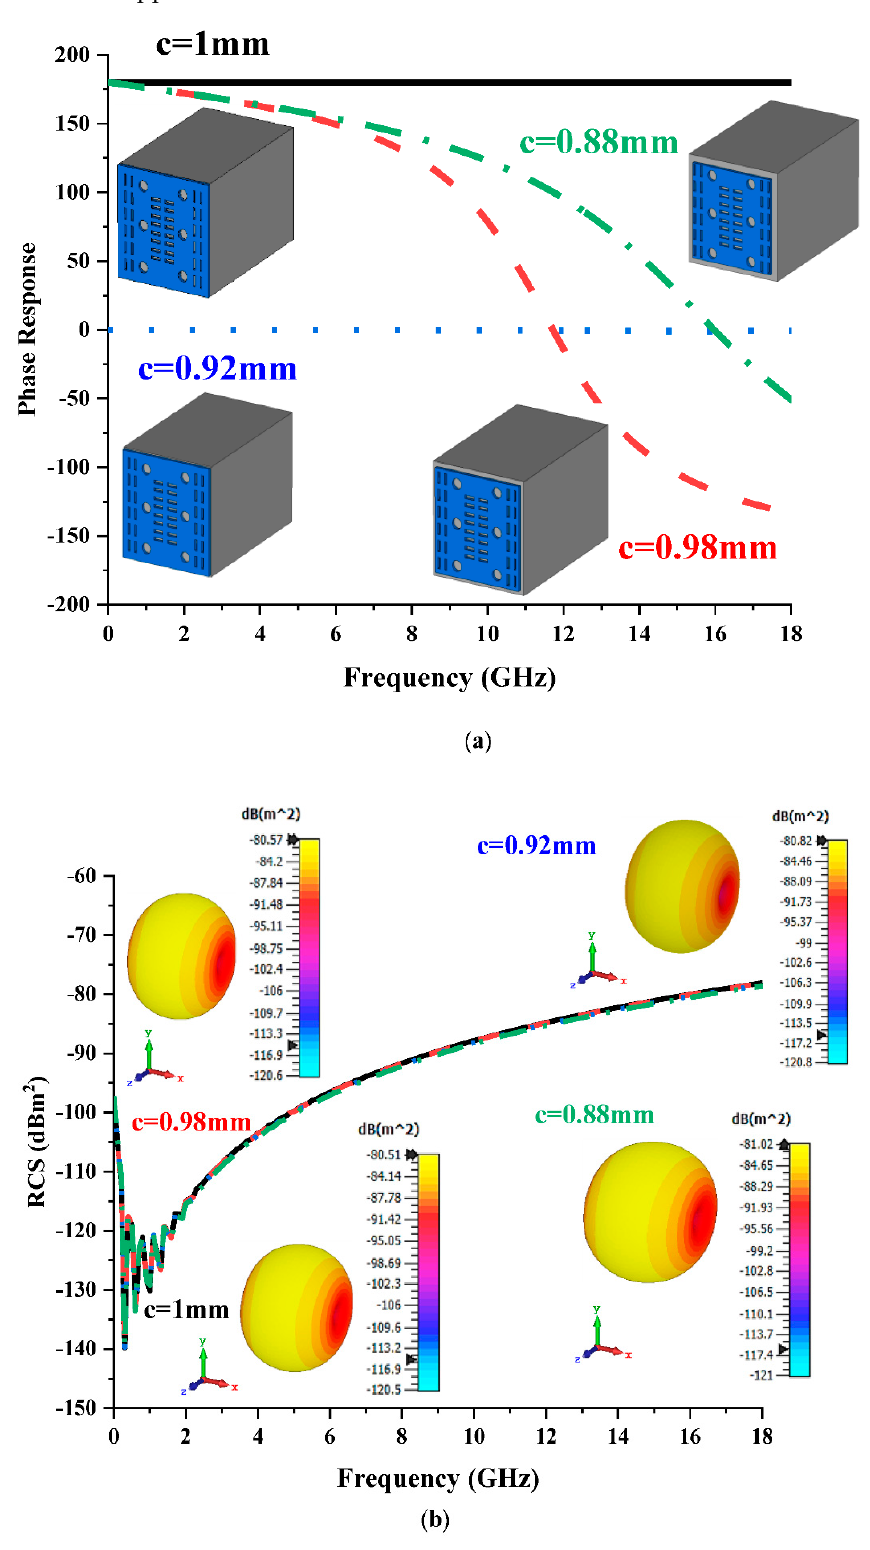
Figure 2. Element ‘1’ with four different c values: ( a ) phase responses; ( b ) monostatic RCS and bistatic scattering pattern at 15 GHz.